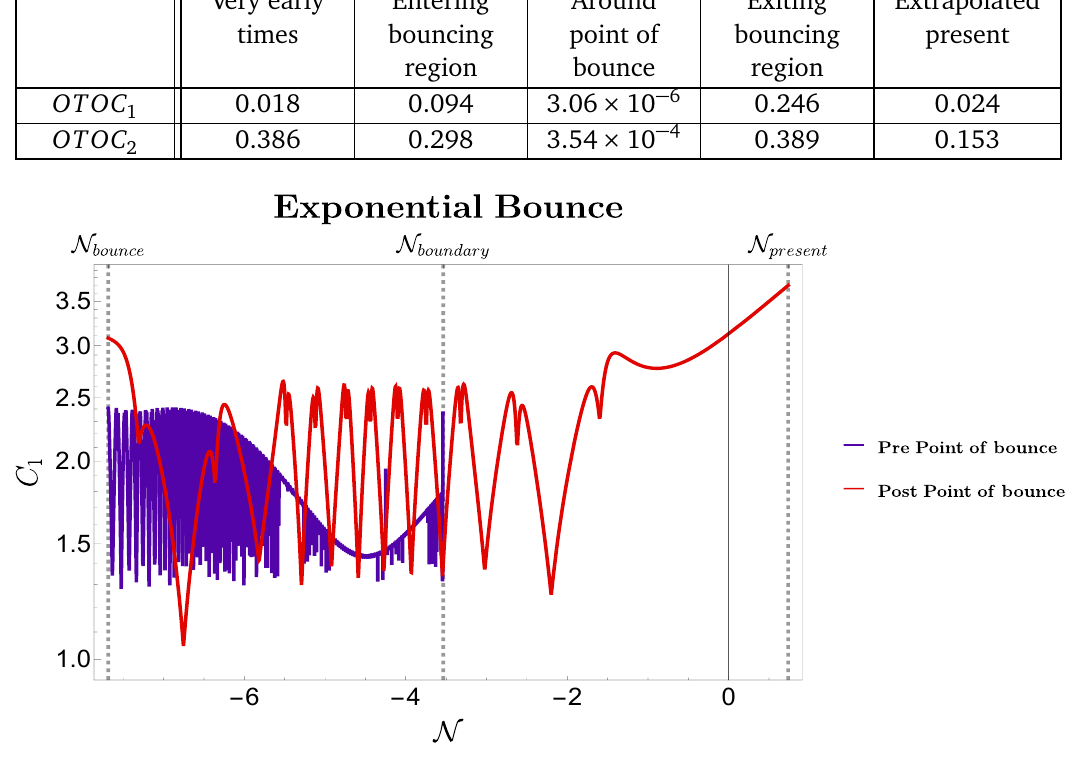
Figure 35: Variation of linearly weighted complexity inside bouncing region with respect to number of e-foldings.